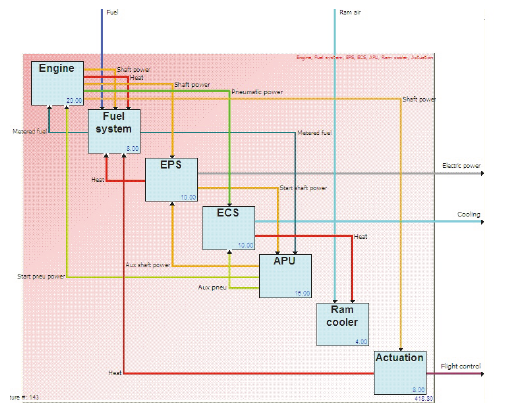
Figure 7: Example architecture of a fixed-wing aeroplane